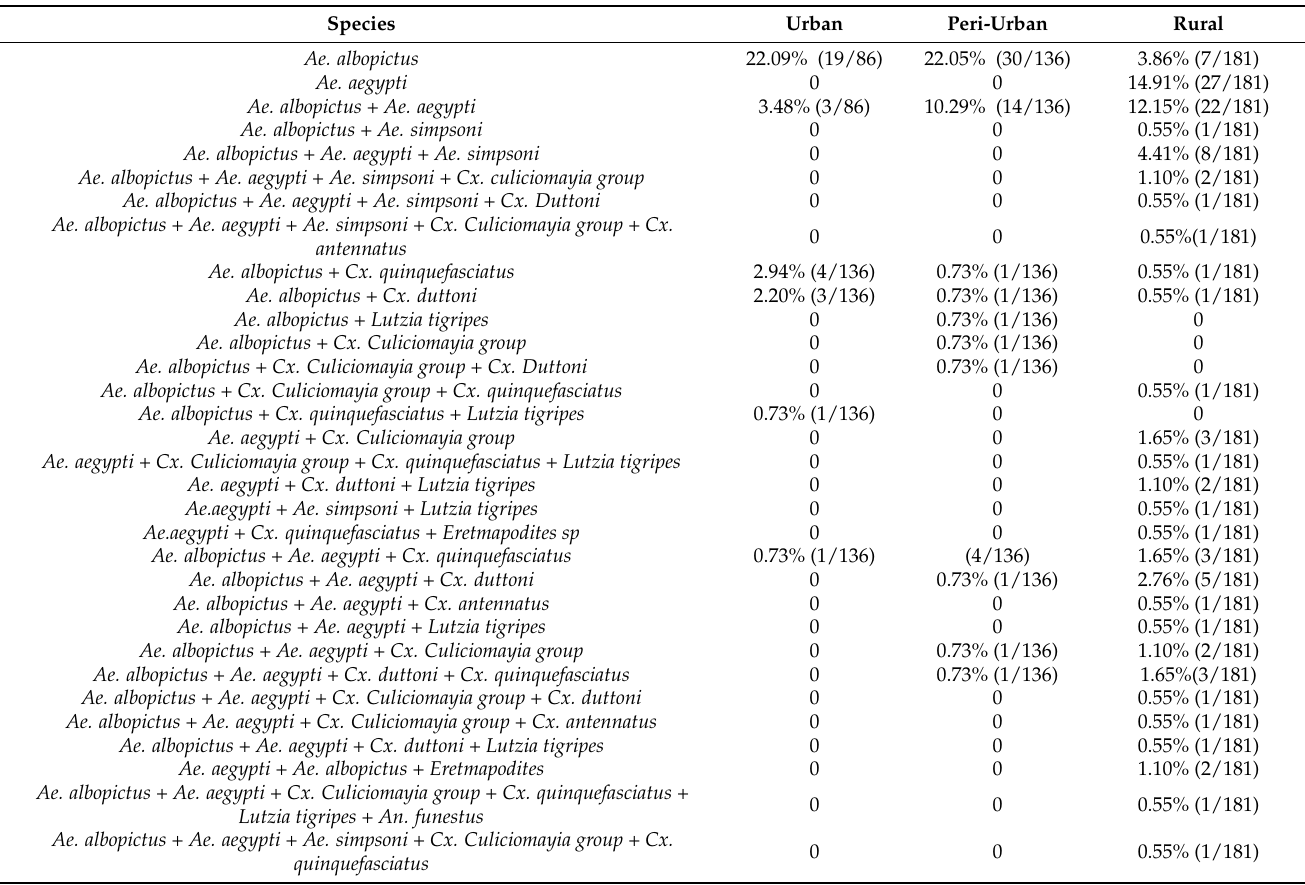
Table 4. Co-occurrences of Aedes species and other species in the same breeding habitats in rural, peri-urban and urban sites in Yaound é .